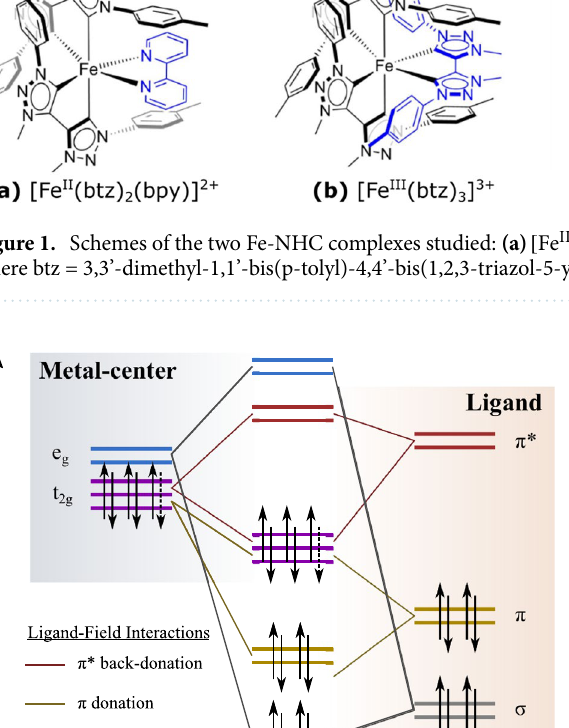
6 5 and open shell 3d electronic